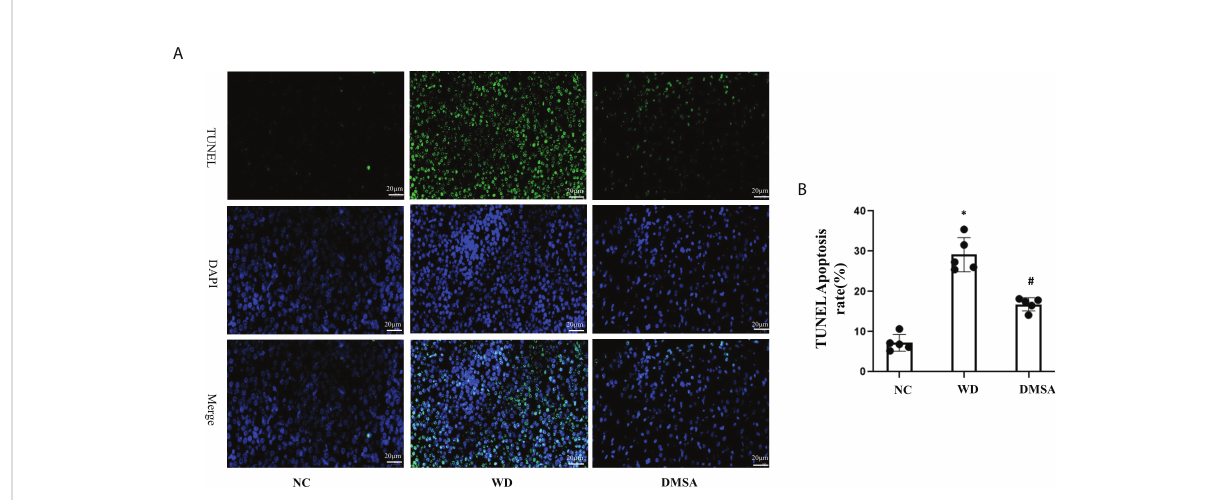
FIGURE 8 Apoptosis analysis of pituitary cells in male mice (A, B) . Data are presented as mean ± SD.(*P<0.05, NC group vs. WD group; # P<0.05, WD group vs. DMSA group).